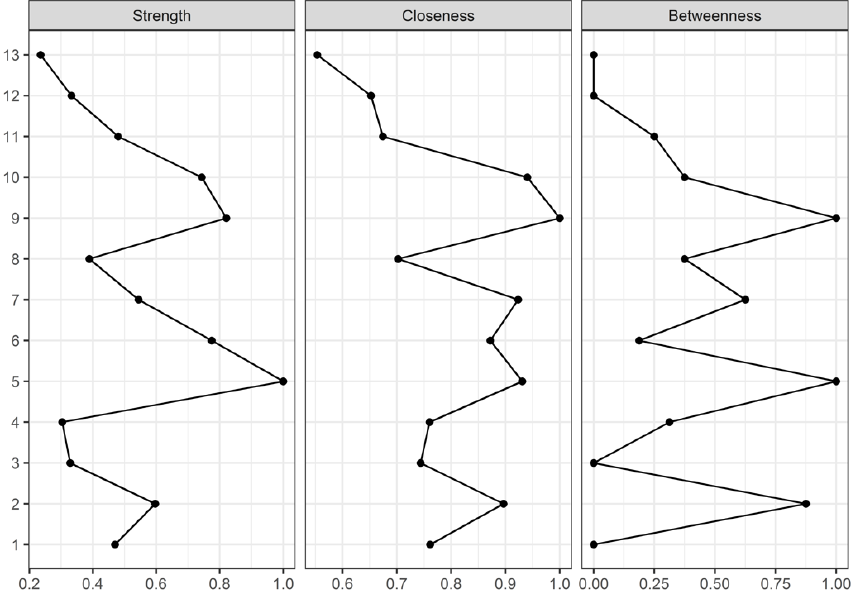
Figure 2. Centrality measures of Strength, Closeness, and Betweenness of each node in the network. Centrality value of 1 indicates maximal importance, and 0 indicates no importance. The nodes’ num- bers are consistent with Figure 1.